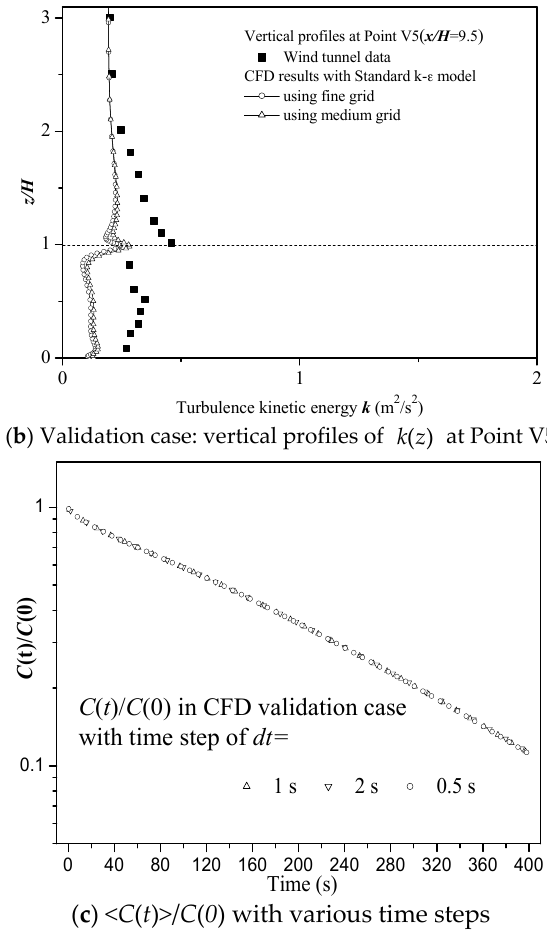
Figure 3. CFD results and experimental data in the CFD validation case: ( a,b ) Vertical profiles of u ( z ) and k z at Point V2 and/or Point V5. ( c ) < C ( t )>/ C (0) with various time steps. Table 2. Statistical performance metrics in CFD validation case.